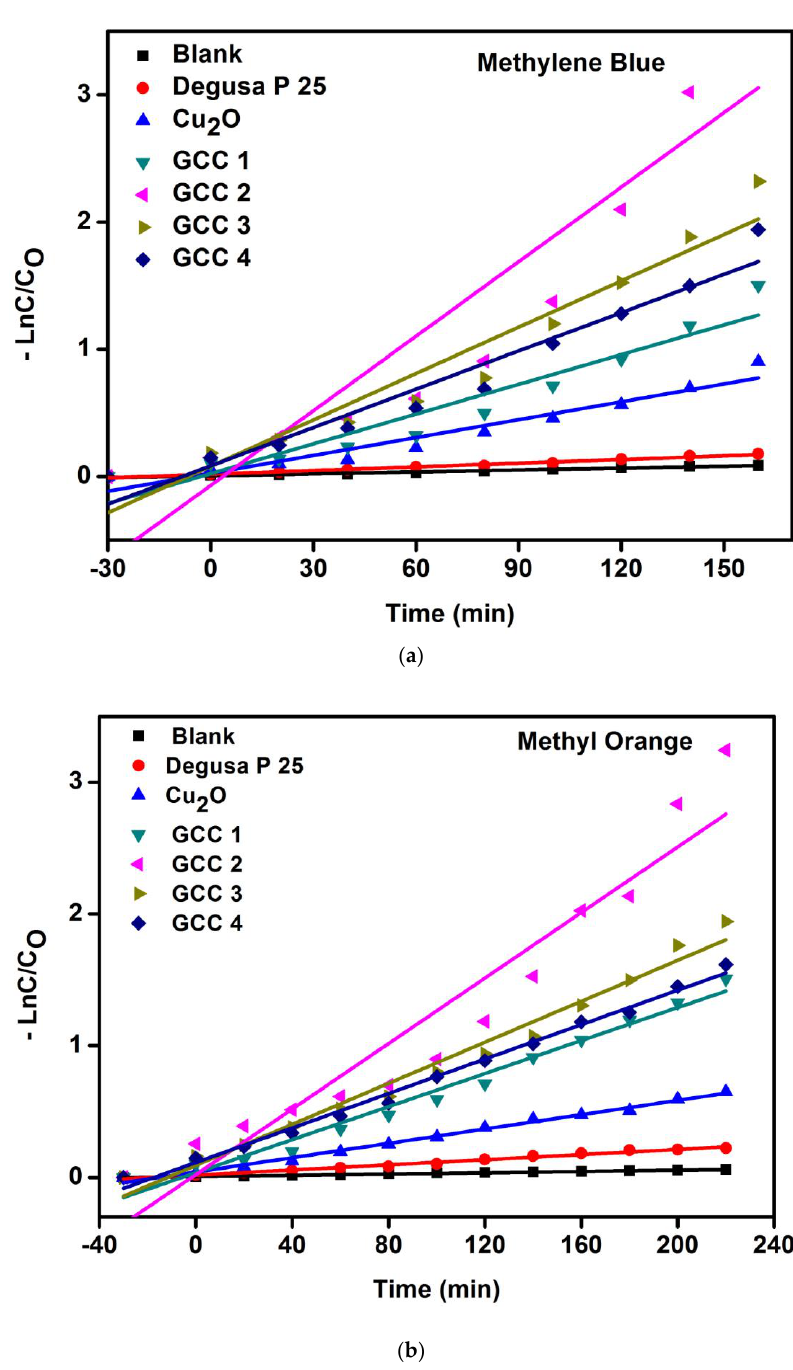
Figure 12. ( a ) Kinetic plot for methylene blue dye. ( b ) Kinetic plot for methyl orange dye. The various rate constant (k abs ) values are given in Table 3, which exposes that the highest value of GCC 2 further confirms the catalytic efficiency of GCC 2 than other